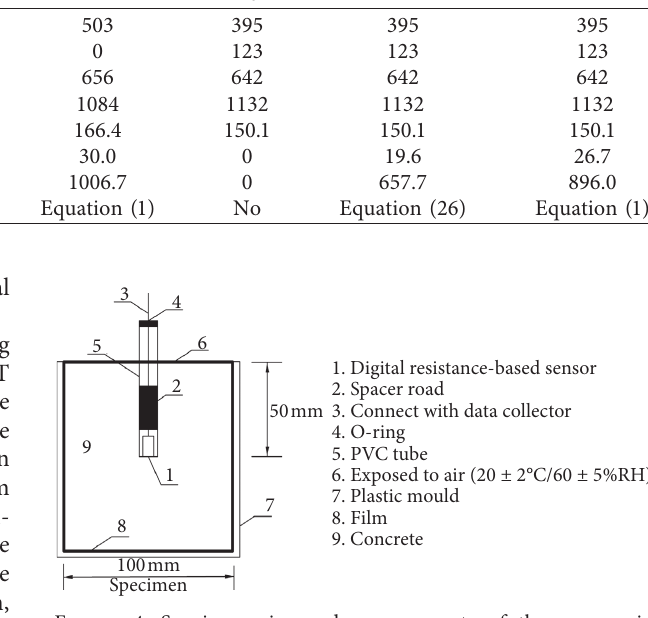
Figure 4: Specimen size and arrangements of the sensors in specimen